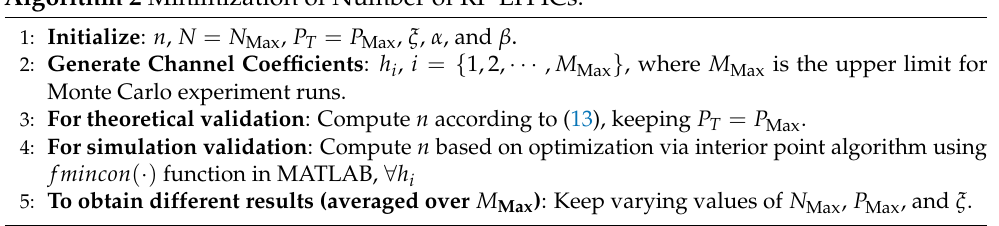
Algorithm 2 Minimization of Number of RF-EH